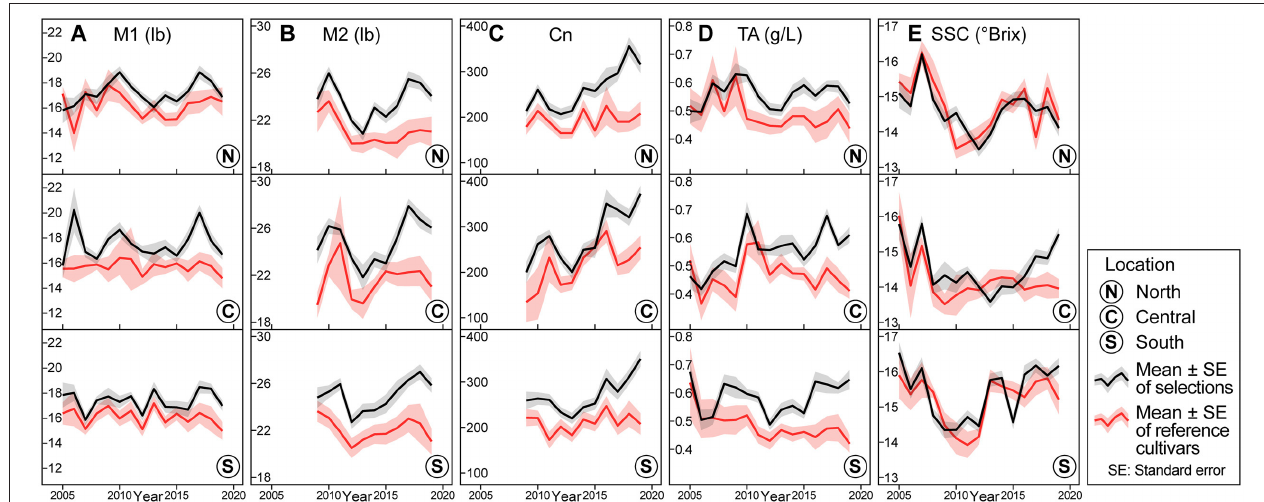
FIGURE 1 | Trends of instrumental fruit quality traits for Washington State University apple breeding program for phase two selections and reference cultivars from 2005 to 2019. Means (as lines) and standard errors (as shades) of selections (in black), and cultivars (in red) for (A) M1—maximum hardness at region one, (B) M2—maximum hardness at region two, (C) Cn—instrumental crispness, (D) TA—titratable acidity, and (E) SSC—soluble solids content.